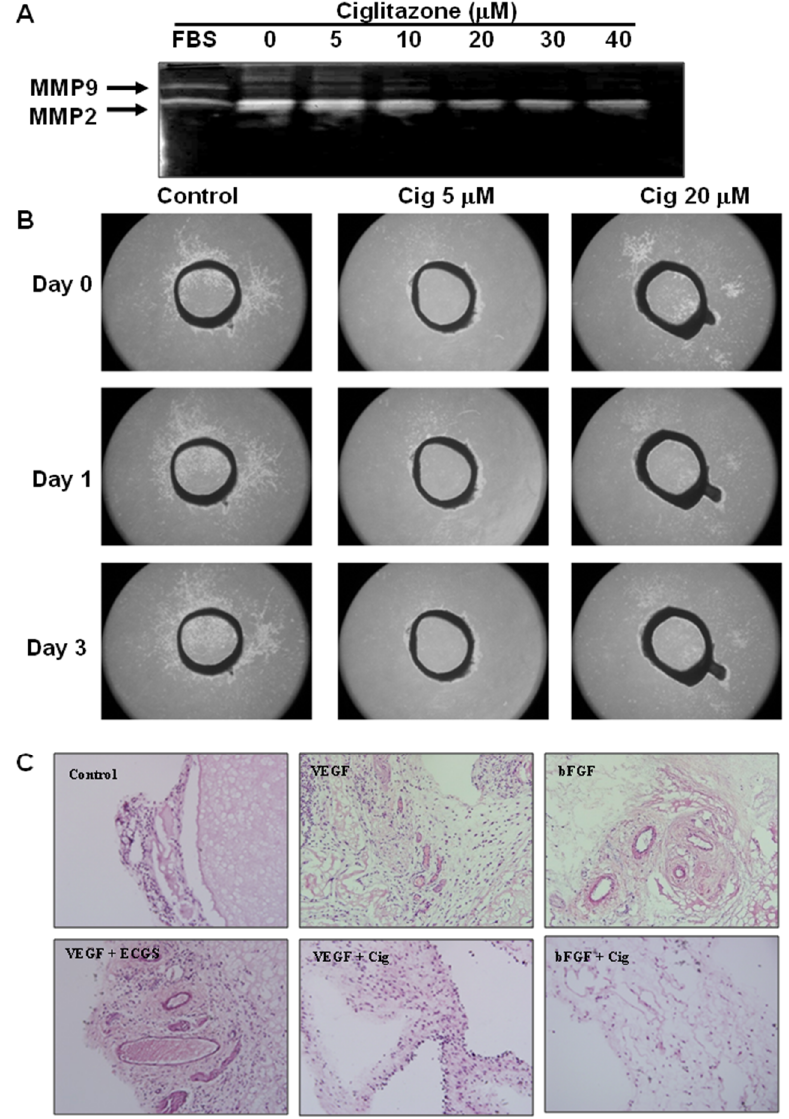
Figure 3. Inhibition of angiogenesis by ciglitazone in vitro and in vivo assay. U87 cells were cultured in serum free media by adding escalated concentration of ciglitazone from 5 to 40 µ M. The media were collected and MMP-2 and MMP-9 activities were analyzed by gelatin zymography. Rat aortic rings were also treated with ciglitazone 5 µ M, or 20 µ M, respectively, and the photography was taken at day 0, day 1, and day 3 under 100 × magnification. In the vivo assay, Matrigel plug sections in mice treated were with VEGF+ ECGS, VEGF, VEGF+ ciglitazone, bFGF, and bFGF+ ciglitazone. ( A ) Representative photography in MMP-2 and MMP-9 activities in gelatin zymography. ( B ) Representative photography in endothelium migration treated with ciglitazone 5 µ M, or 20 µ M related to different time points of day 0, day 1, and day 3 under 100 × magnification. ( C ) Representative images of hematoxylin and eosin (HE) stained in Matrigel plug sections in mice treated with VEGF+ ECGS, VEGF, VEGF+ ciglitazone, bFGF, and bFGF+ ciglitazone. Control as a negative control; VEGF+ ECGS as a positive control. The photography was taken under 200 ×